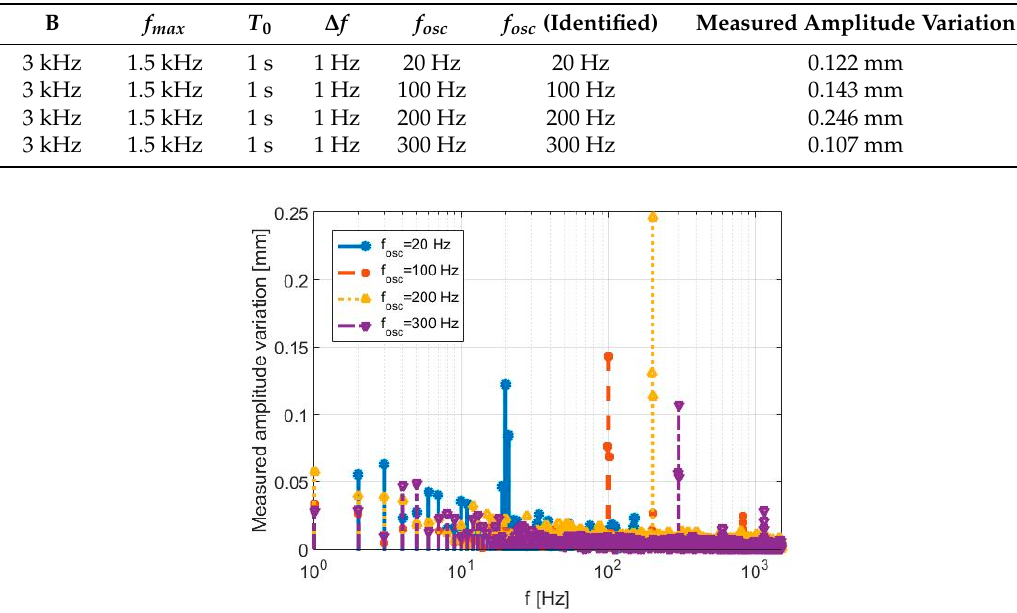
Figure 12. Parameters and results of the first experimental validation tests (first set).